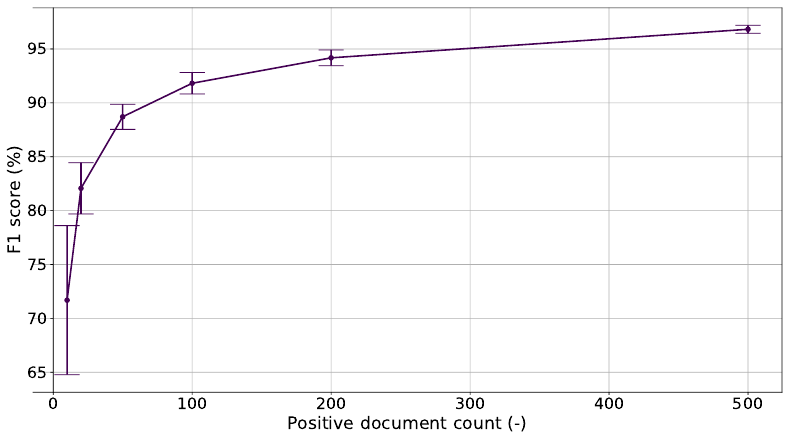
Figure 4. Effect of positive document counts on classifier